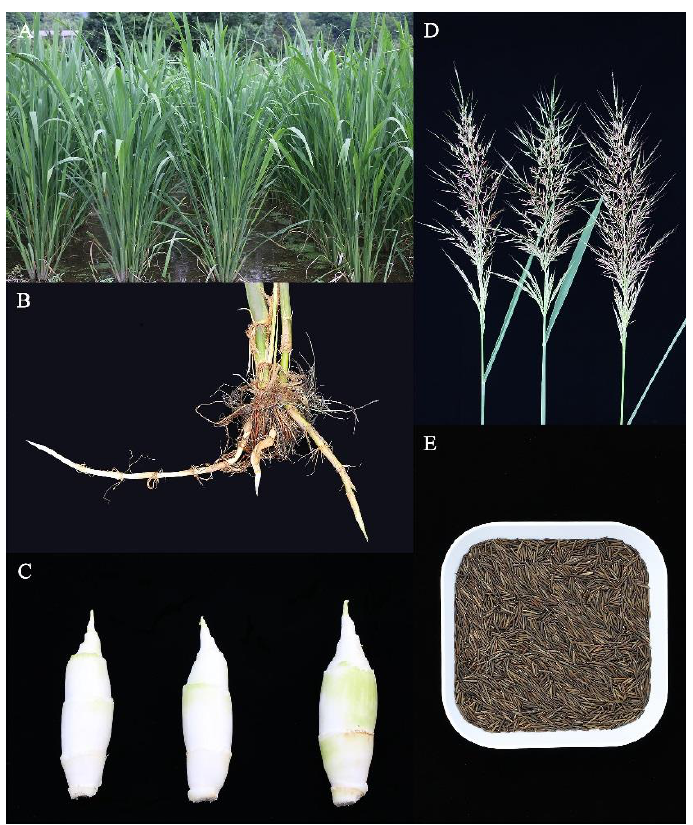
Figure 1. Aerial parts ( A ); rhizome ( B ); swollen culm ( C ); inflorescence ( D ); and seeds ( E ) of Z. latifolia .